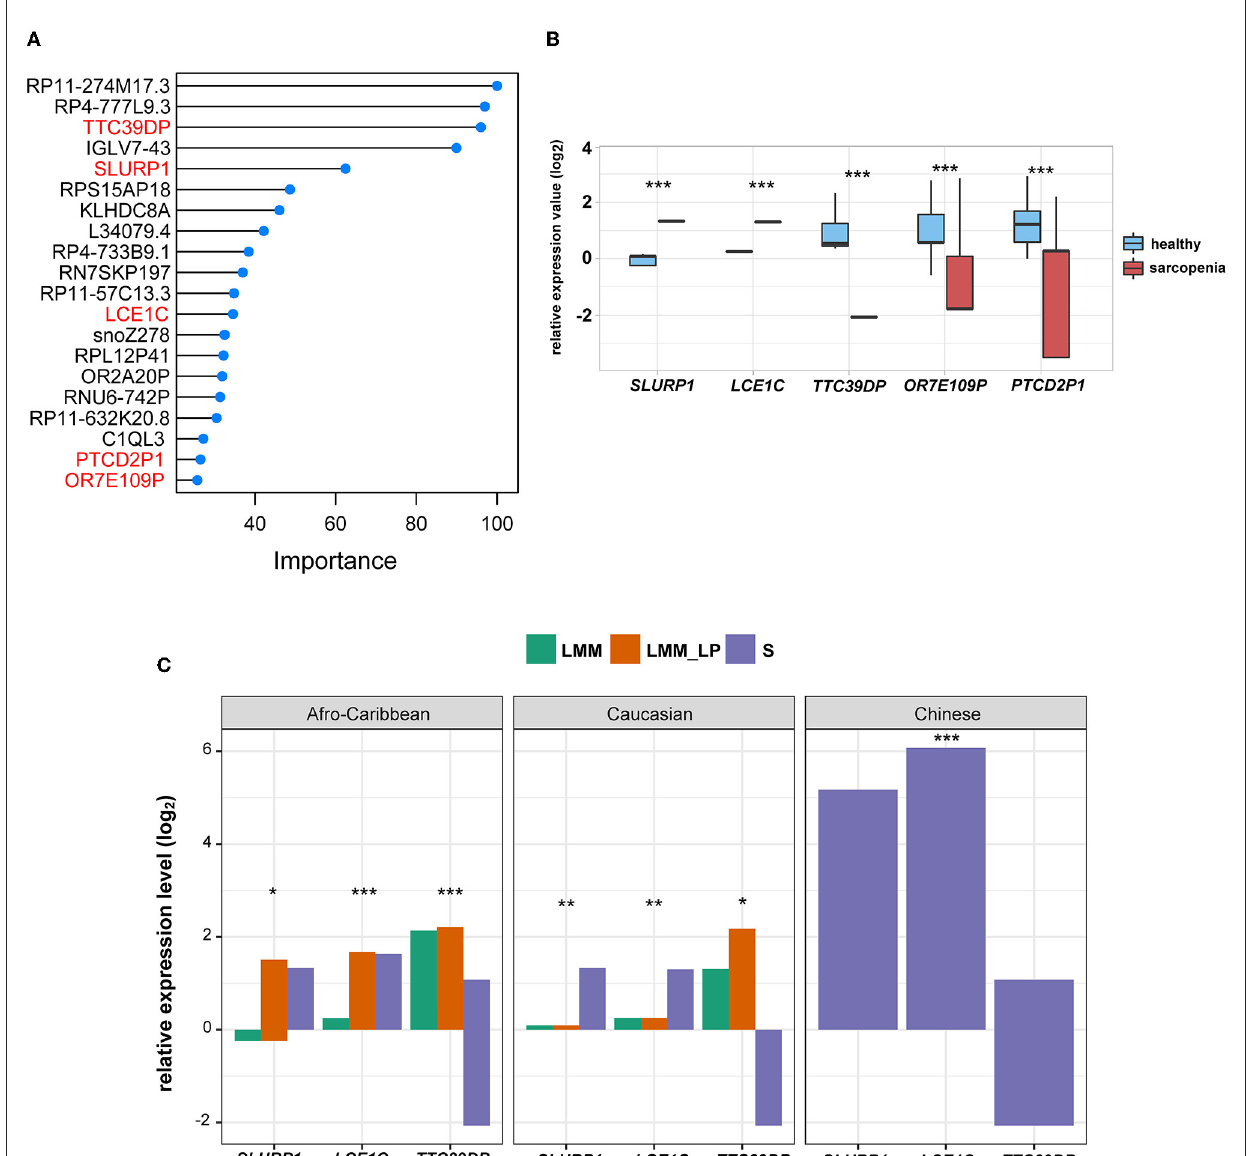
FIGURE2 Discrimination of sarcopenia from healthy states using elastic net regression model and the association of the novel biomarkers with patient’s ethnicity. (A) The elastic regression model discriminates sarcopenia from a healthy control based on gene expression profile. Model importance was identified as regression coefficients. (B) Comparison of the expression levels of the top-ranked genes between sarcopenia and the healthy controls between differentially expressed gene analysis and the elastic net regression model ( t -test, p -values are shown. * p < 0.5, ** p < 0.01, and *** p < 0.001). (C) Comparison of the expression levels of SLURP1 , LCE1C , and TTC39DP among the S, LMM, and LMM_LP groups (ANOVA test, p-values are shown. * p < 0.5, ** p < 0.01, and *** p <